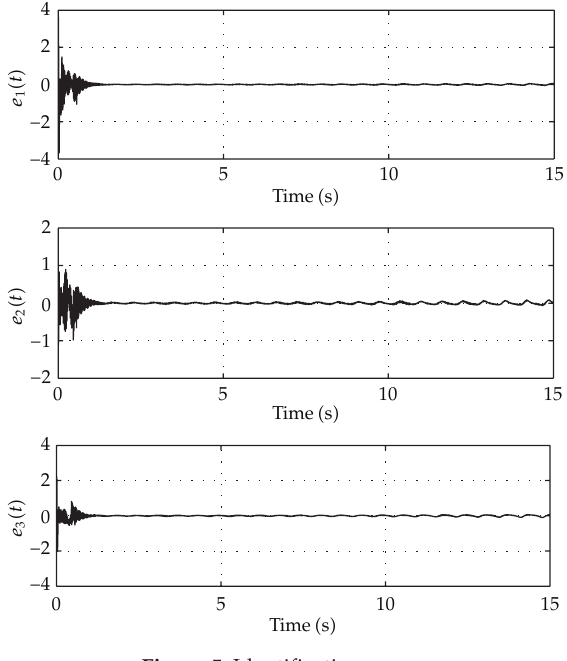
Figure 5: Identification